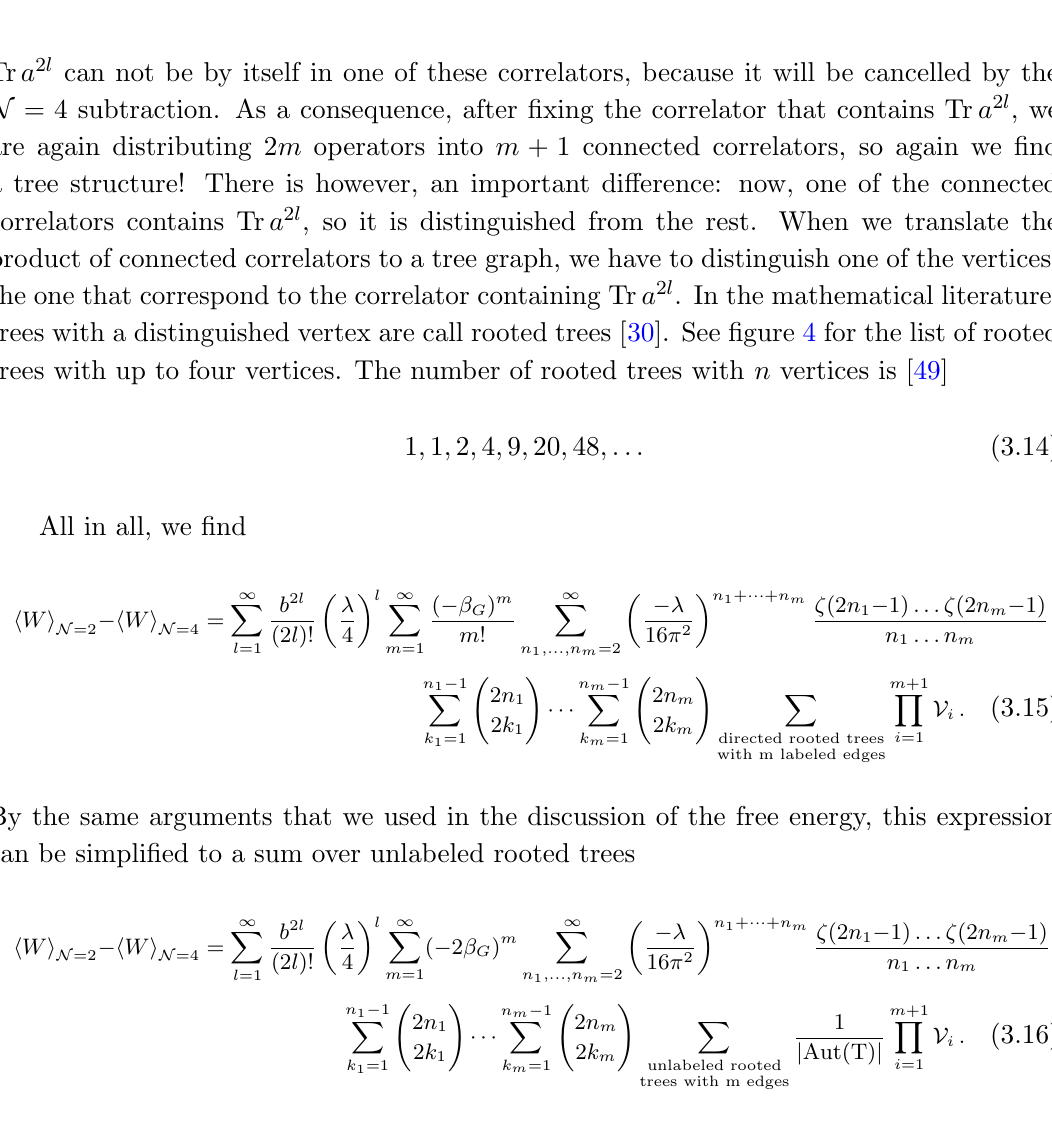
Figure 4 . The list of rooted trees up to 4 vertices. In each tree, the distinguished vertex is represented by the white